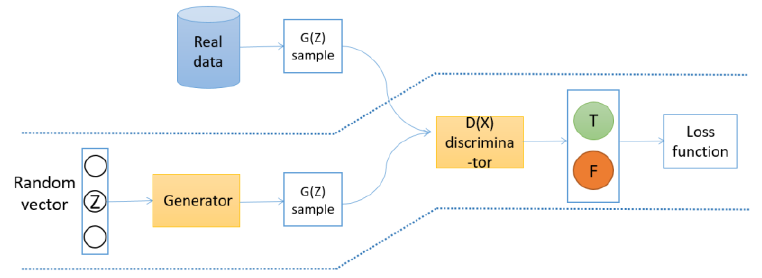
Figure 3. Overview of the